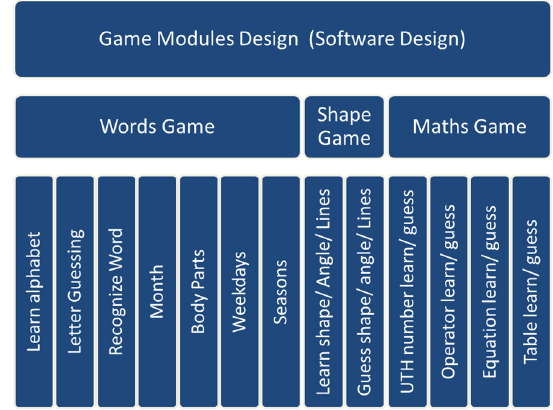
Fig.3 : Game Modules incorporated in software for optical braille